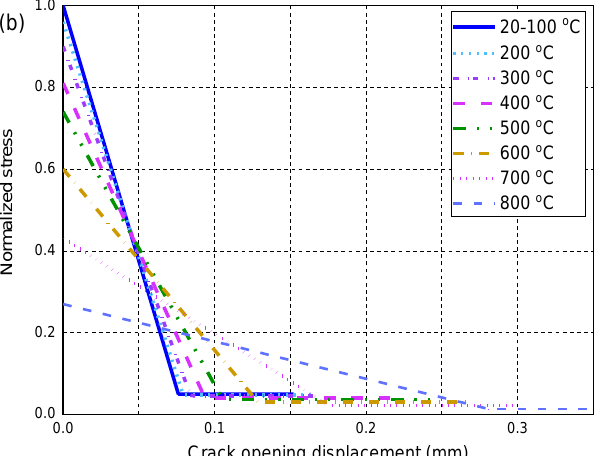
Figure 2. Mechanical properties of concrete at ambient and high temperatures: ( a ) normalized compressive stress–strain curves; ( b ) normalized tensile stress–crack opening displacement curves.